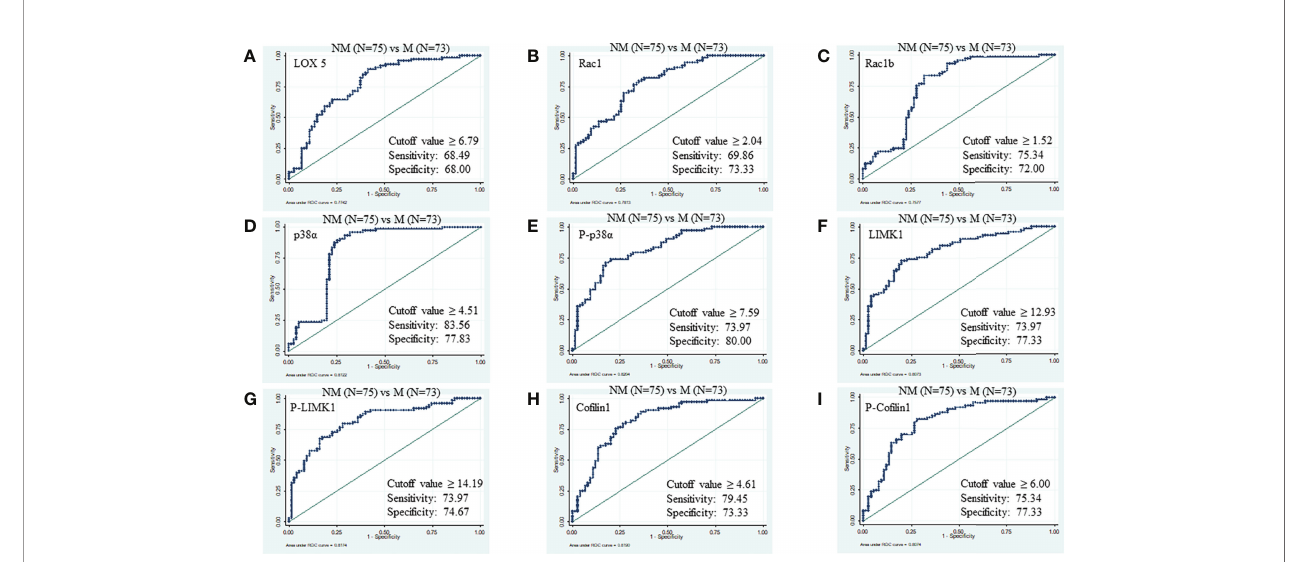
FIGURE 3 | ROC of serum proteins between NM and M. (A) LOX5; AUC: 0.774, (B) Rac1; AUC: 0.781, (C) Rac1b; AUC: 0.757, (D) p38 a ; AUC: 0.812, (E) phospho-p38 a (Y-182); AUC: 0.820, (F) LIMK1, AUC: 0.807 (G) phospho-LIMK1 (T-508); AUC: 0.817, (H) Co fi lin1; AUC: 0.819, (I) phospho-Co fi lin1 (S-3); AUC: 0.807.